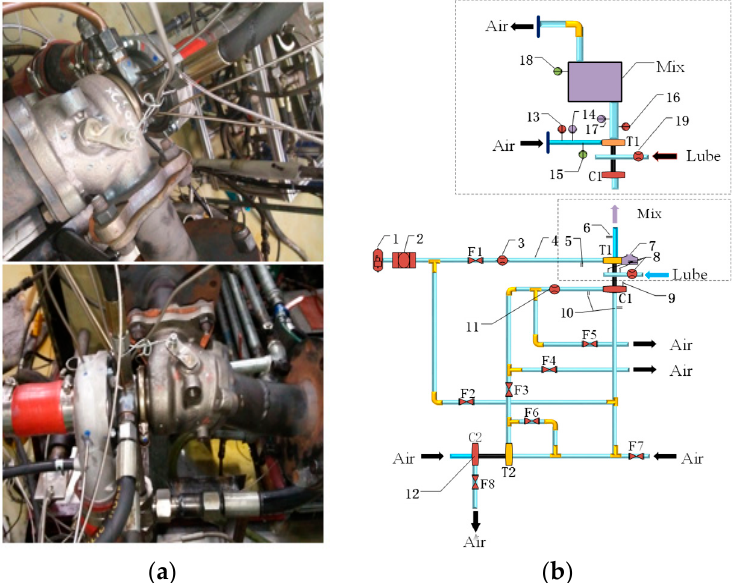
Figure 4. Schematic of the turbine test: ( a ) turbine test layout; ( b ) schematic diagram of the test bench. 1. Air supply; 2. Air cleaner; 3. Flowmeter; 4. Electric heater; 5. Turbine inlet section; 6. Turbine outlet section; 7. Test turbine; 8. Lubricating oil section; 9. Rotational speed meter; 10. Compressor section; 11. Flowmeter; 12. Auxiliary turbocharger; 13. Static pressure sensor; 14. Total pressure sensor; 15.Total temperature sensor; 16. Static pressure sensor; 17. Total pressure sensor; 18. Total temperature sensor; 19. Flowmeter.